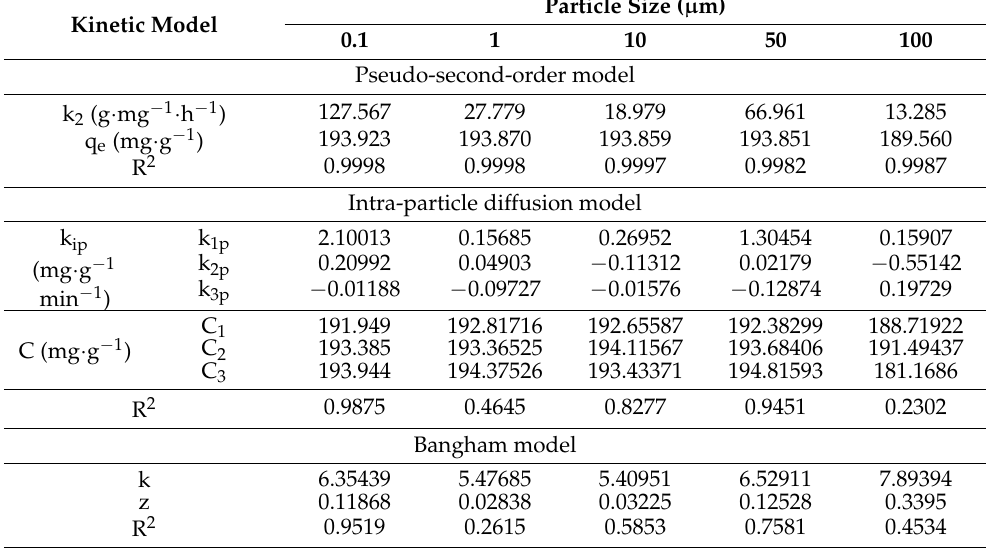
Figure 3. The effect of PS-MP particle size ( A ), initial NP concentration ( B ), solution pH ( C ), and metal ions contained in the solution ( D ) on the adsorption process of NP. * indicates the significant difference between the treatment group (0.1 μm PS-MPs, initial NP concentration of 4 mg/L, pH 7 and control without metal ions, respectively) and other groups (* p < 0.05, ** p < 0.001, *** p < 0.0005). Table 2. Kinetic parameters of NP adsorption by the PS-MPs obtained from the pseudo-second-order, Intra-particle diffusion and Bangham